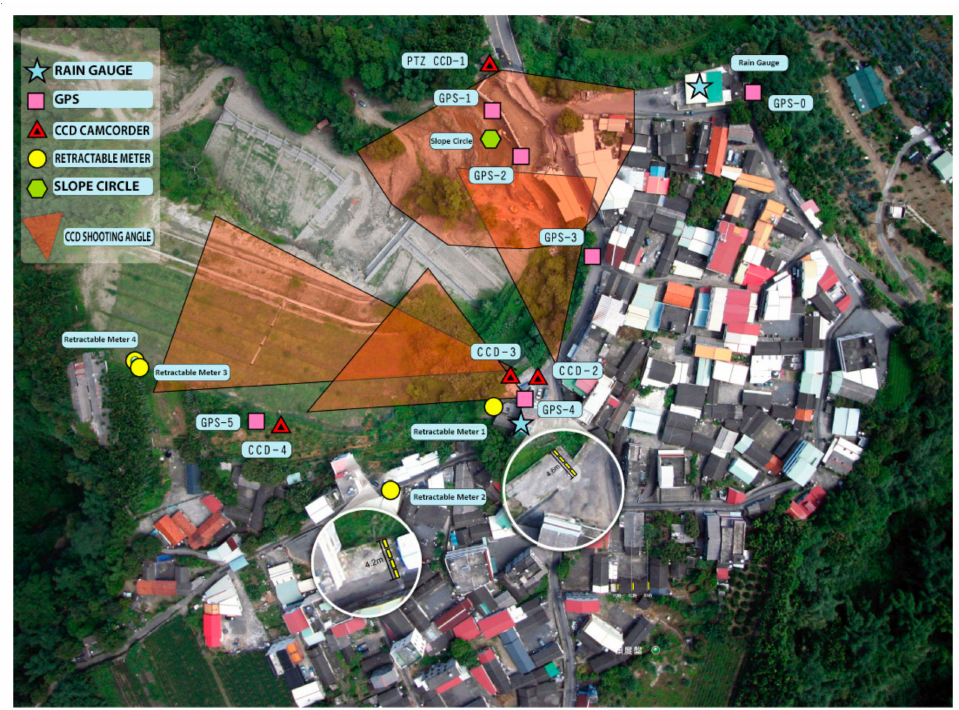
Figure 5. Arrangement of the devices presented in Pingding. The monitoring station is equipped with a rain gauge, a CCD camcorder, a high-pressure tiltmeter, a remote camcorder, a geophone, and slope circles (dual